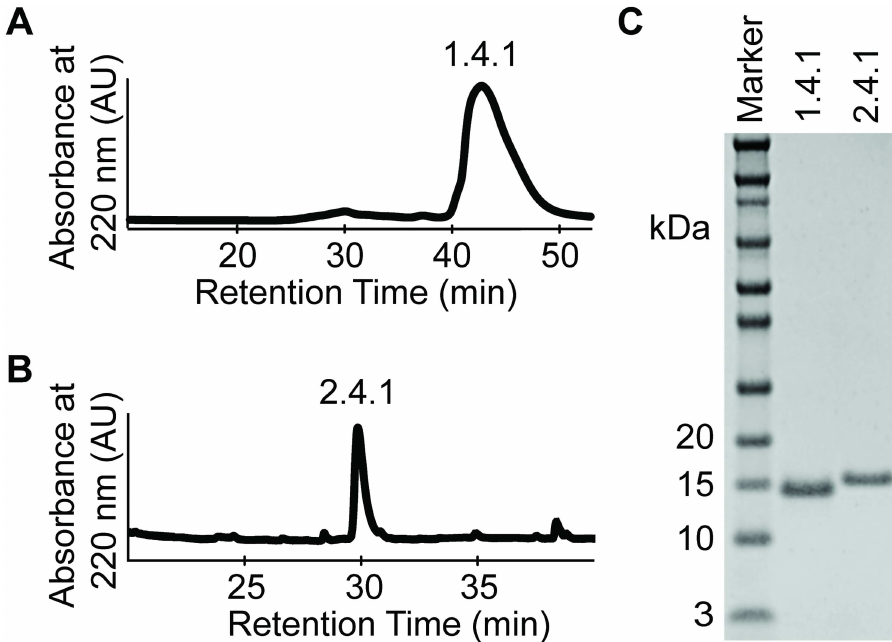
Fig 4. Production and characterization of selected Fn3 variants. Engineered Fn3 clones 1.4.1 and 2.4.1 were expressed in bacteria with a C-terminal hexahistidine tag and a short peptide tag containing GKSK residues for